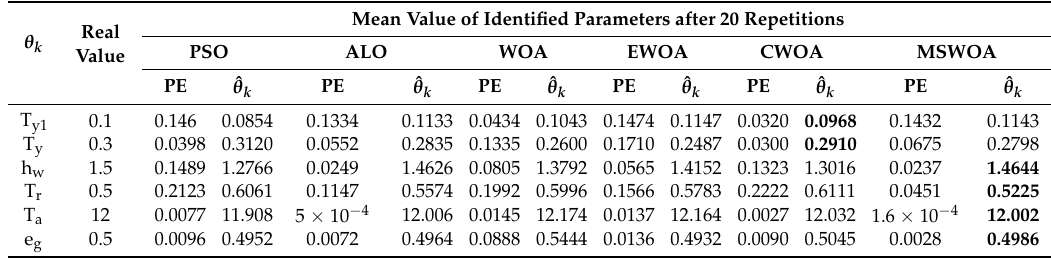
Table 12. Mean identified parameters under load conditions.